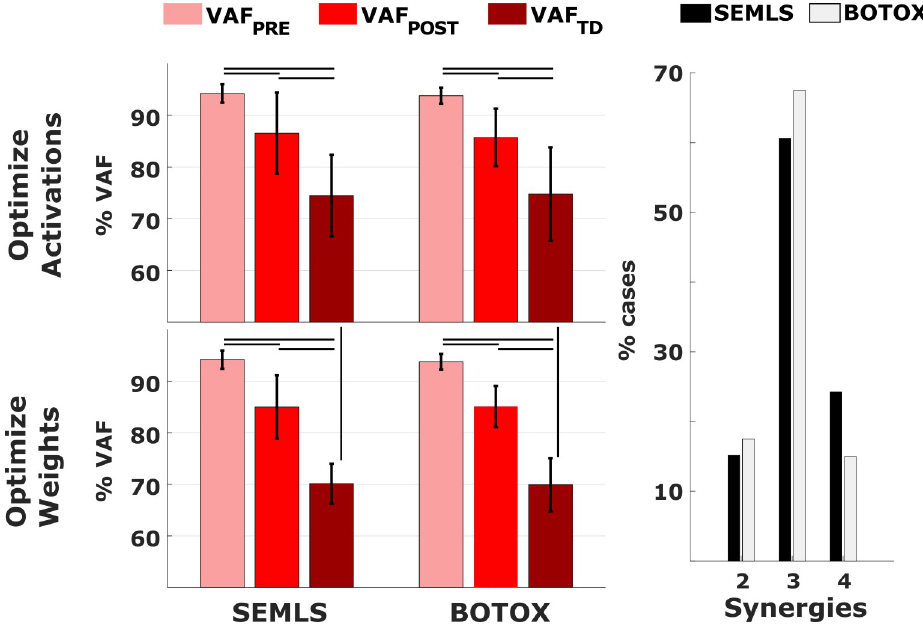
Fig 2. VAF values and number of synergies. On the left, mean and standard deviations for the VAF values in the PRE, POST and TD conditions, split acoording to the treatment and the reconstruction method. There were no significant differences in the VAF values between the BOTOX and SEMLS groupsBlack lines indicate significant differences (p < 0.05). On the right, number of synergies explaining the pre-treatment EMG